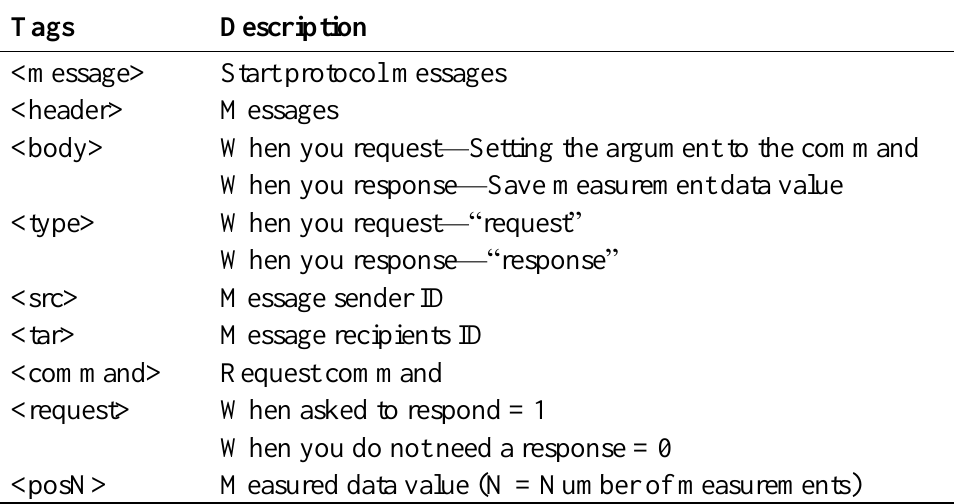
Table 4. XML message format for data